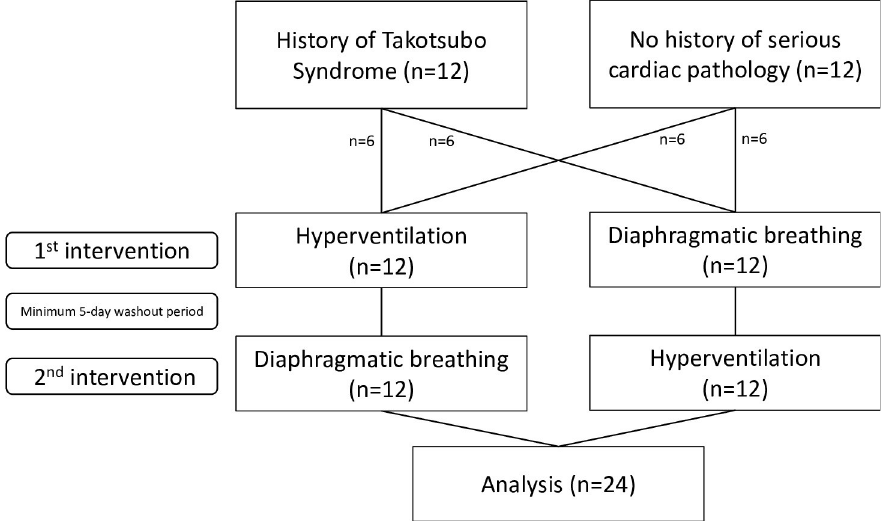
Fig 1. CONSORT flowchart showing number of patients recruited, assigned to each intervention, and analysed.